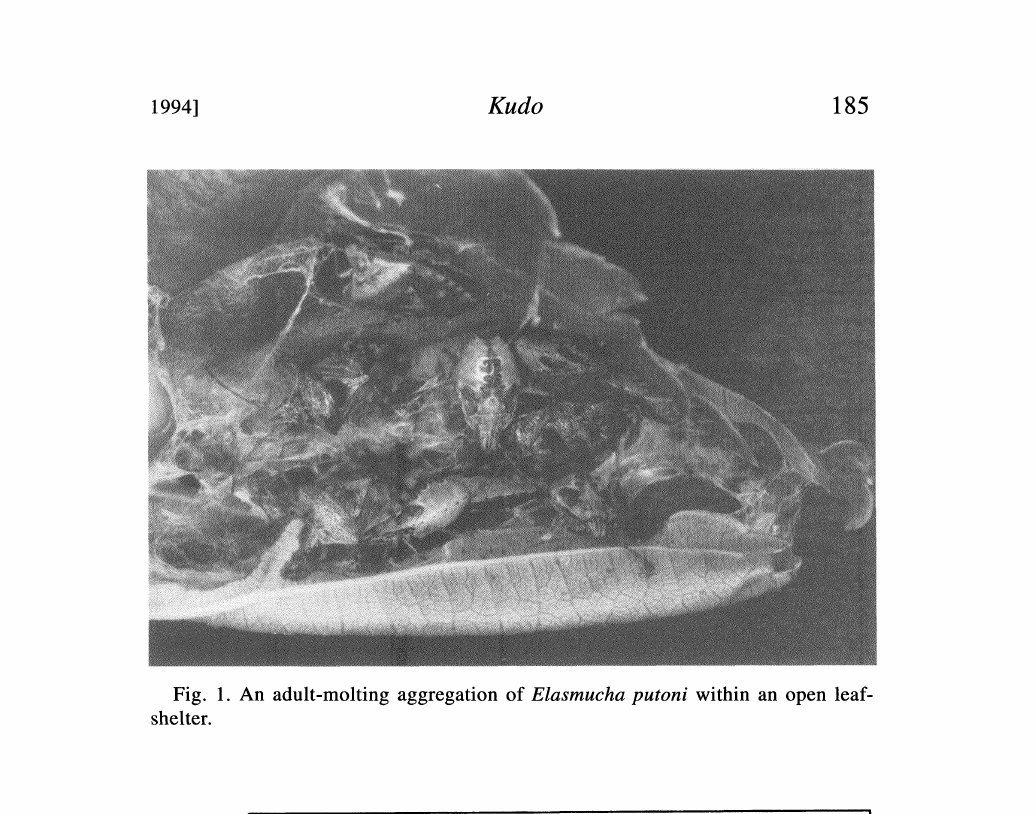
Fig. 1. An adult-molting aggregation of Elasmucha putoni within an open leaf- shelter.